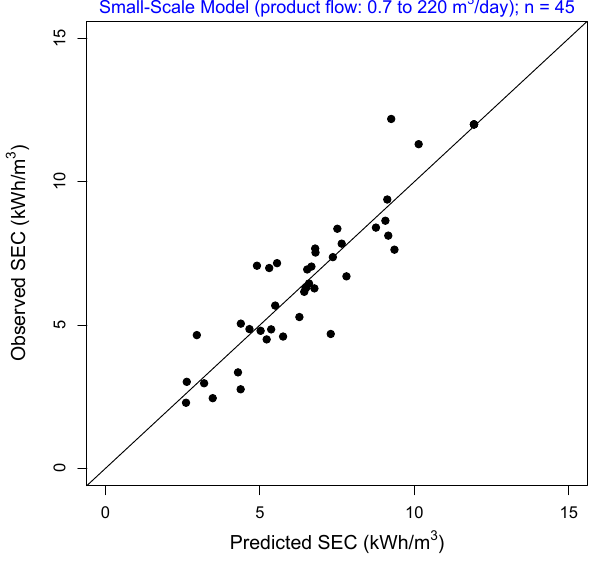
Figure 1. Our model for small-scale desalination operations predicts energy consumption consistent with observed energy